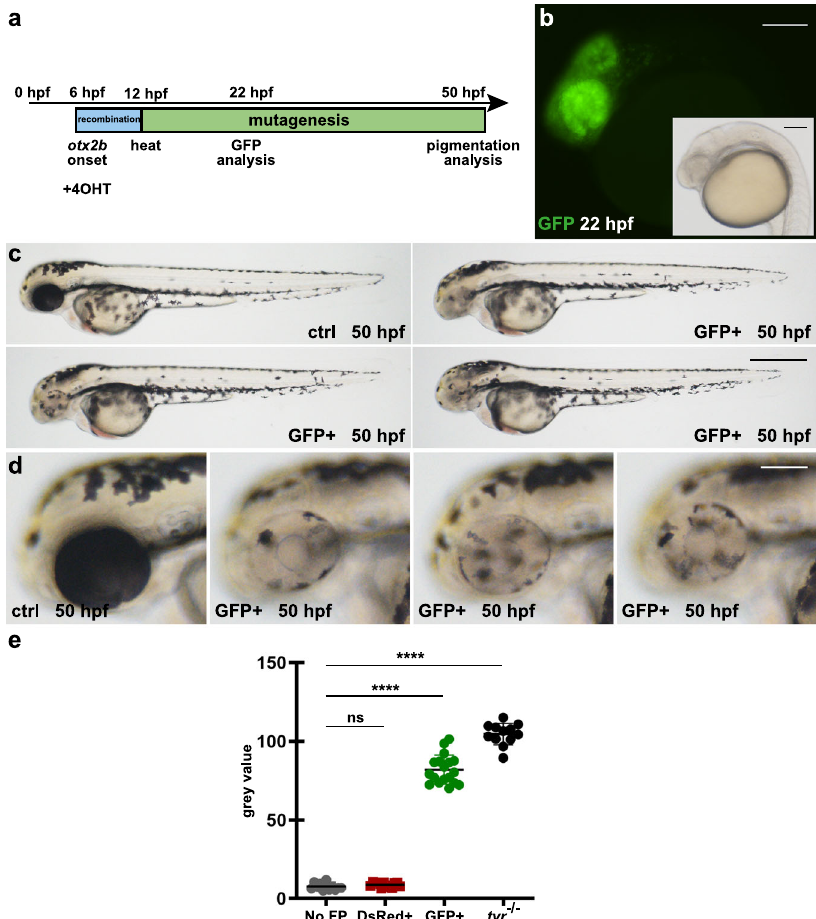
Fig. 5 otx2b -speci fi c Cre activity results in spatiotemporally controlled GFP expression and pigmentation defects in the developing eyes. a Timeline. Application of 4-Hydroxytamoxifen (4OHT) induces Cre activity in otx2b :CreER T2 -positive animals at 6 hpf eliciting recombination (blue box) in cells of the developing anterior neural plate. At 12 hpf, a heat treatment triggers expression of Cas9-GFP and the subsequent mutagenesis of the tyr target site (green box). Analysis of GFP expression and pigmentation was conducted at 22 and 50 hpf, respectively. b Expression of GFP is detected in cells of the developing fore-, midbrain and eyes at 22 hpf. c , d In comparison to controls (ctrl), GFP-positive embryos (GFP + ) display no pigmentation loss in cells along the body, but signi fi cant pigmentation defects in the developing eyes. Examples shown are representatives across ten experiments showing the same result. A total of >200 GFP-positive individuals and their respective non-GFP-positive siblings were analyzed. Scale bars: 150 µ m in b and d ; 500 µ m in c . e Graph showing quanti fi cation of RPE pigmentation determined using the mean of the histogram from images of control embryos expressing no fl uorescent protein (Non-FP), DsRed-positive (DsRed + ), and GFP-positive (GFP + ) siblings as well as tyrosinase mutants ( tyr − / − ) at 50 hpf. n (Non-FP, DsRed + , tyr − / − ) = 12; n (GFP + ) = 18. Data were analyzed using one-way ANOVA, followed by Tukey ’ s post hoc test. Values are presented as mean ± SEM; **** p ≤ 0.0001, ns (non-signi fi cant) =